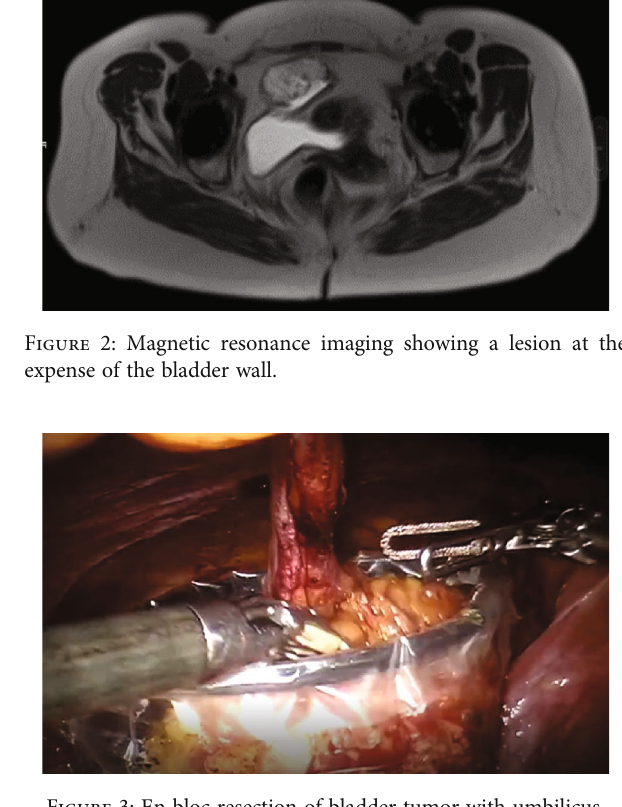
Figure 3: En bloc resection of bladder tumor with